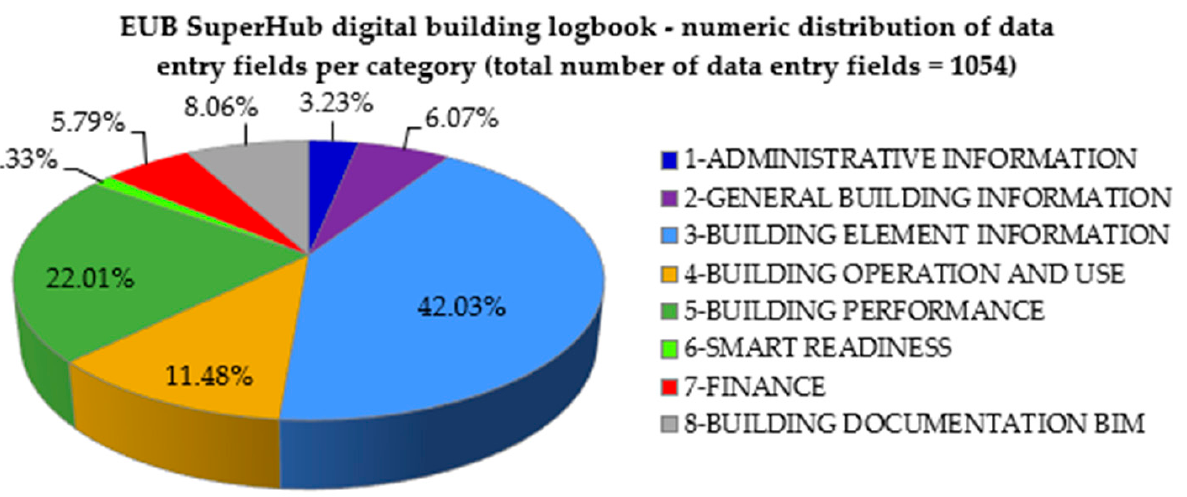
Figure 4. SuperHub digital building logbook data—numeric distribution of data entry fields per category.